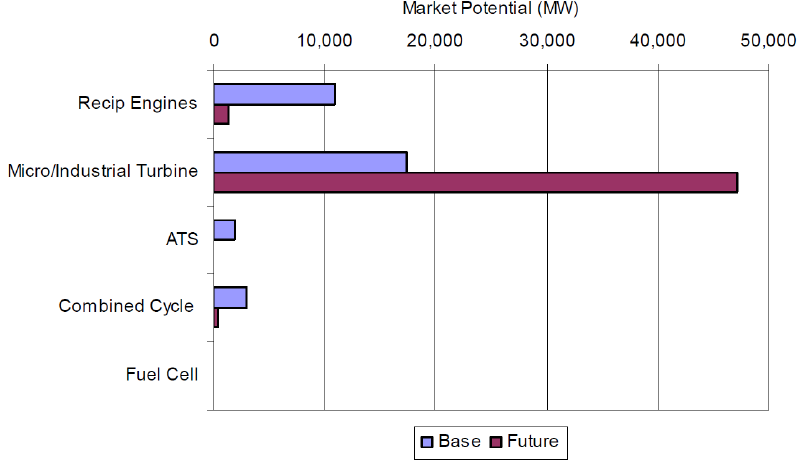
Figure 6. Market potential by technology, base data were collected in 2002 [43].